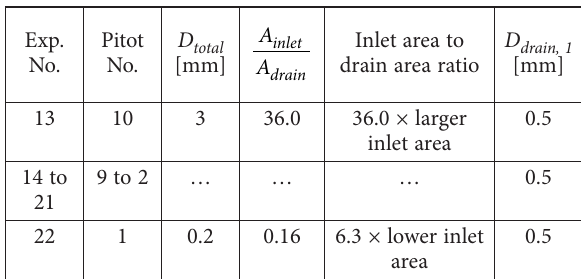
Table 3. Experiments with a 0.5 mm drain hole opened and